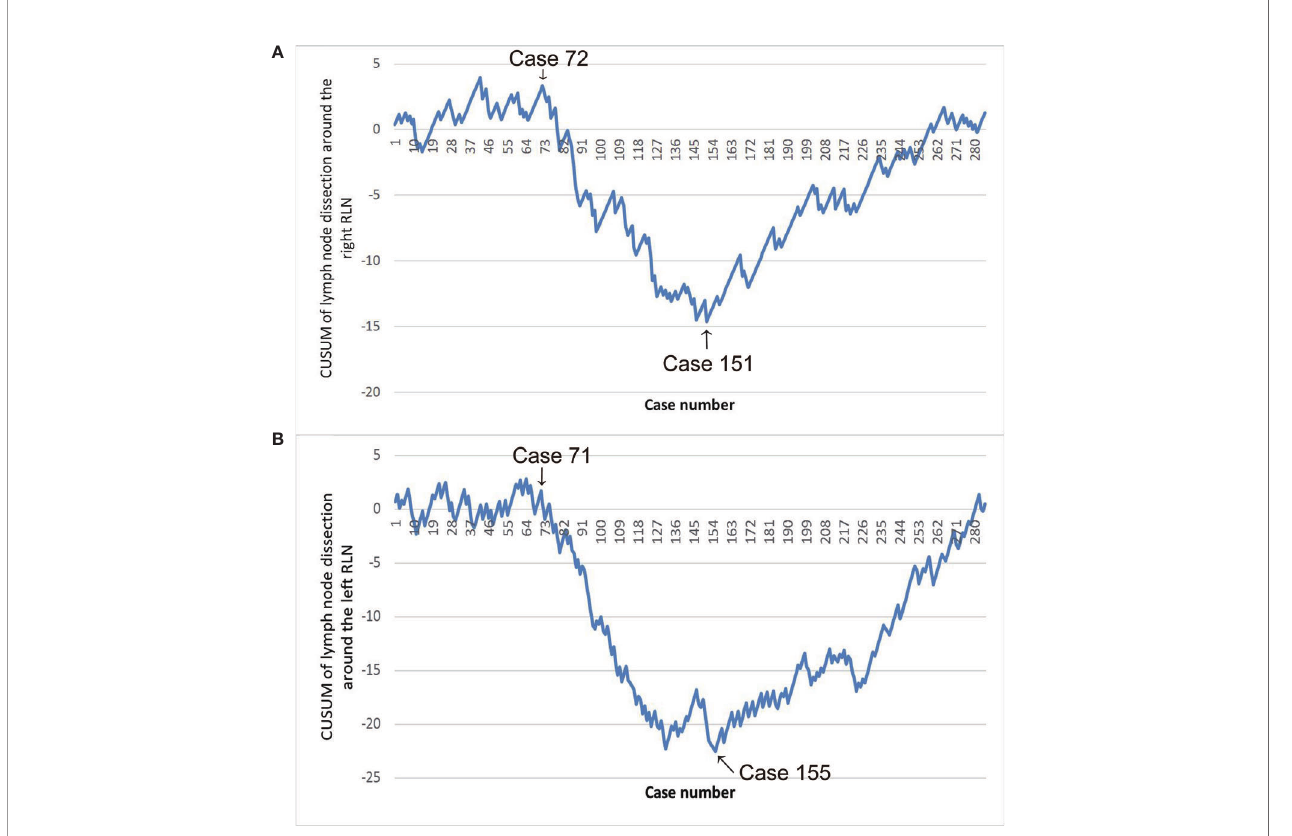
FIGURE 1 | (A) Learning curve of lymph nodes (LN) dissection around the right RLN. (B) Learning curve of LN dissection around the left